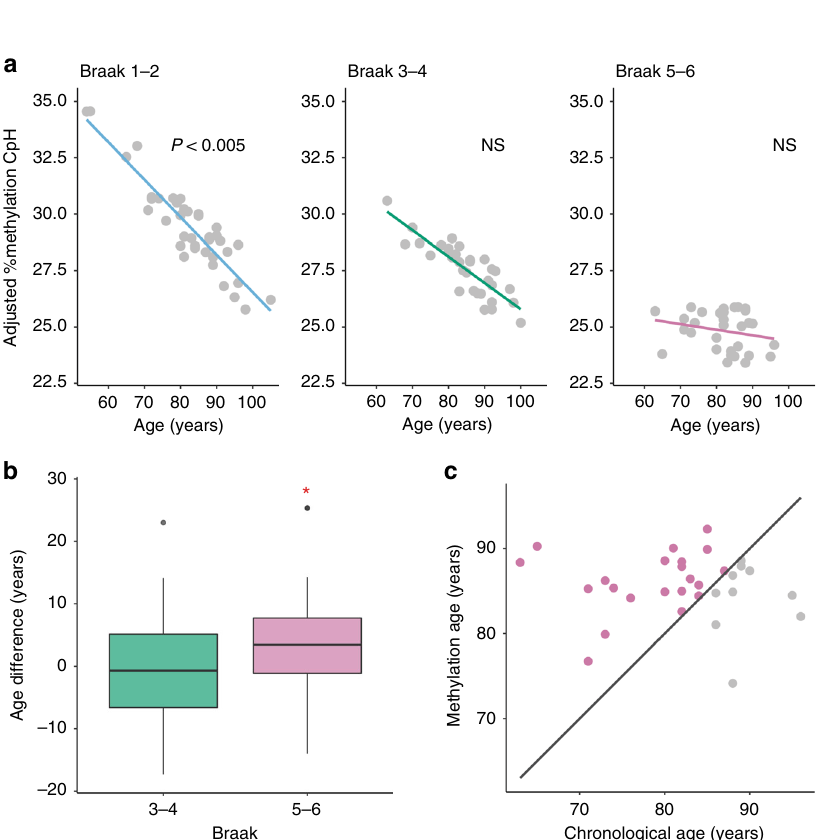
Fig. 6 Accelerated CpH methylation changes with aging in AD neurons. Age-dependent changes in CpH methylation in neurons from individuals with no/ mild, moderate, and severe AD pathology (Braak stage 1 – 2, 3 – 4, 5 – 6, and n = 38 individuals, 32, and 31 individuals, respectively). Age analysis was performed on CpH sites ( n = 3661 CpHs) in enhancers relevant to AD ( n = 848 enhancers showing both epigenetic and associated gene transcript differences in AD, as identi fi ed by Omics integration analysis). a Aging changes in % CpH methylation at enhancers in neurons. CpH methylation decreased with age in individuals with no/mild AD pathology ( p < 0.005, robust linear regression model), but not in moderate or severe AD. Analysis of % CpH methylation changes with age adjusted for sex, postmortem interval, and neuronal proportion. b Box plot showing the difference between the epigenetic age and chronological age in neurons of moderate and severe AD cases. The epigenetic aging calculator 17 used CpH sites to determine the epigenetic ages of the moderate and severe AD groups. CpH methylation aging was accelerated in severe AD neurons ( p < 0.05, paired t -test). The boxplot center line is the median, the lower and upper limits are the fi rst and third quartiles (25th and 75th percentiles), and the whiskers are 1.5× the interquartile range. c CpH methylation age relative to chronological age in neurons of severe AD cases (Braak stage 5 – 6). Each dot represents a severe AD case, and the line demarks where chronological age matches epigenetic age. Purple dots are samples in which epigenetic age is greater than chronological age.